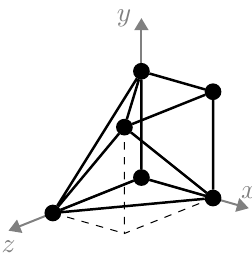
Figure 7 . Toric diagram for H 4